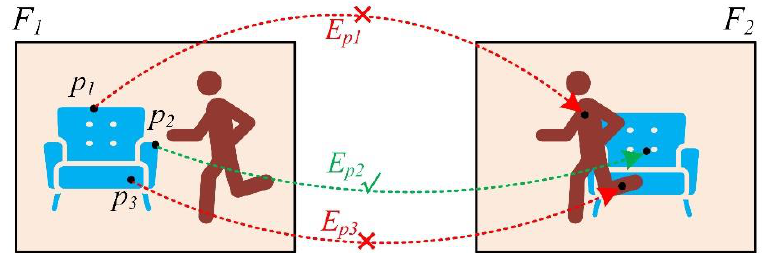
Figure 5. F 1 is a keyframe. p 1 , p 2 and p 3 are candidate points extracted according to Section 4.1. F 2 is the subsequent frame of F 1 . Three points are projected to F 2 to form three residuals. If the projection point falls in the dynamic region of F 2 , the corresponding residual will be removed.